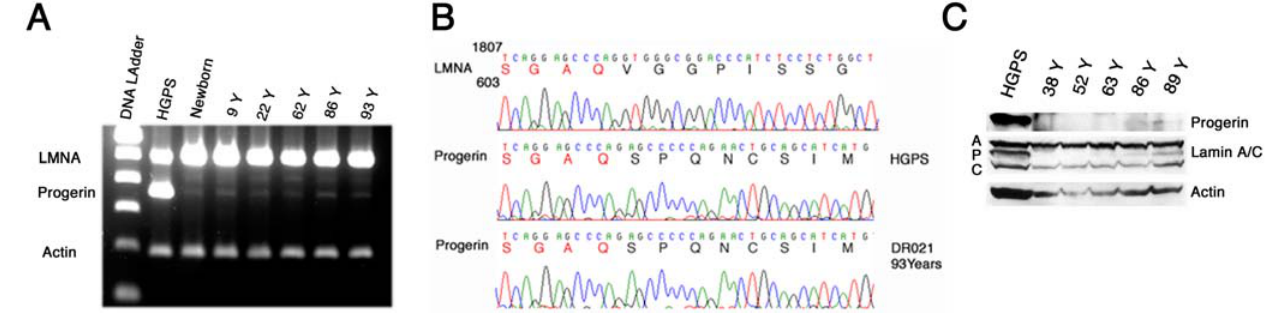
Figure 1. Progerin expression in human skin. A , RT-PCR analysis of HGPS cells and human skin biopsies of indicated age, primers amplifying wild- type and progerin transcripts. B , Direct sequencing of a short portion within exon 11 of wild type lamin A (LMNA), and progerin transcripts from HGPS and 93-year-old subjects. C , Western blot analysis of protein extracted from skin biopsies of indicated age with anti-progerin 972S9, anti-lamin A/C and anti-actin